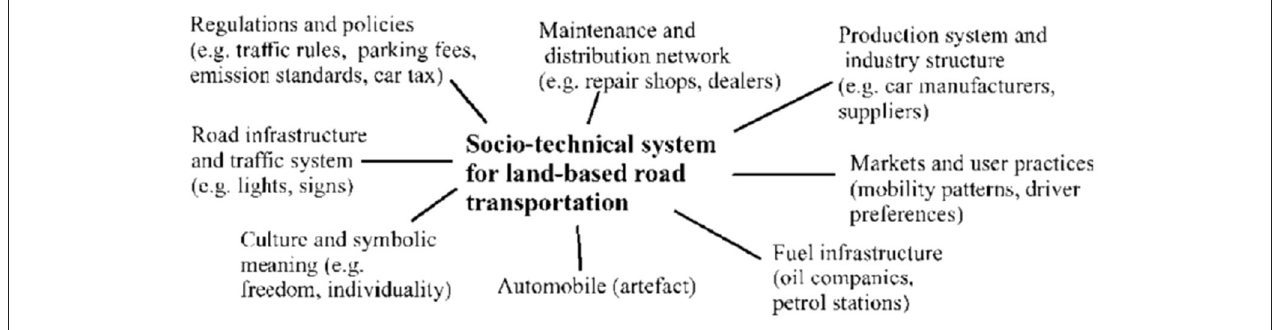
FIGURE 4 | Socio-technical system transition in the context of modern road transportation. Source: Geels (2005).